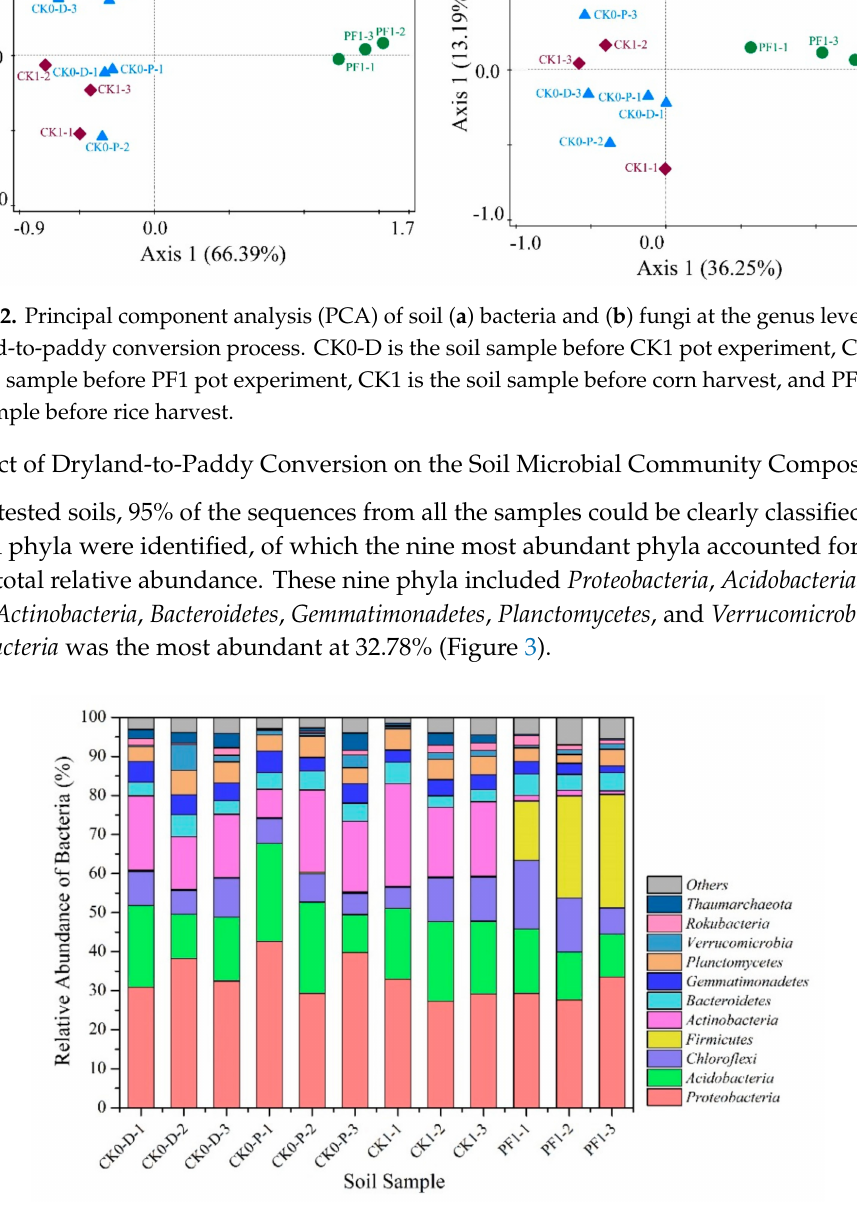
Figure 3. Changes in the relative abundance of bacterial phyla in the dryland-to-paddy conversion